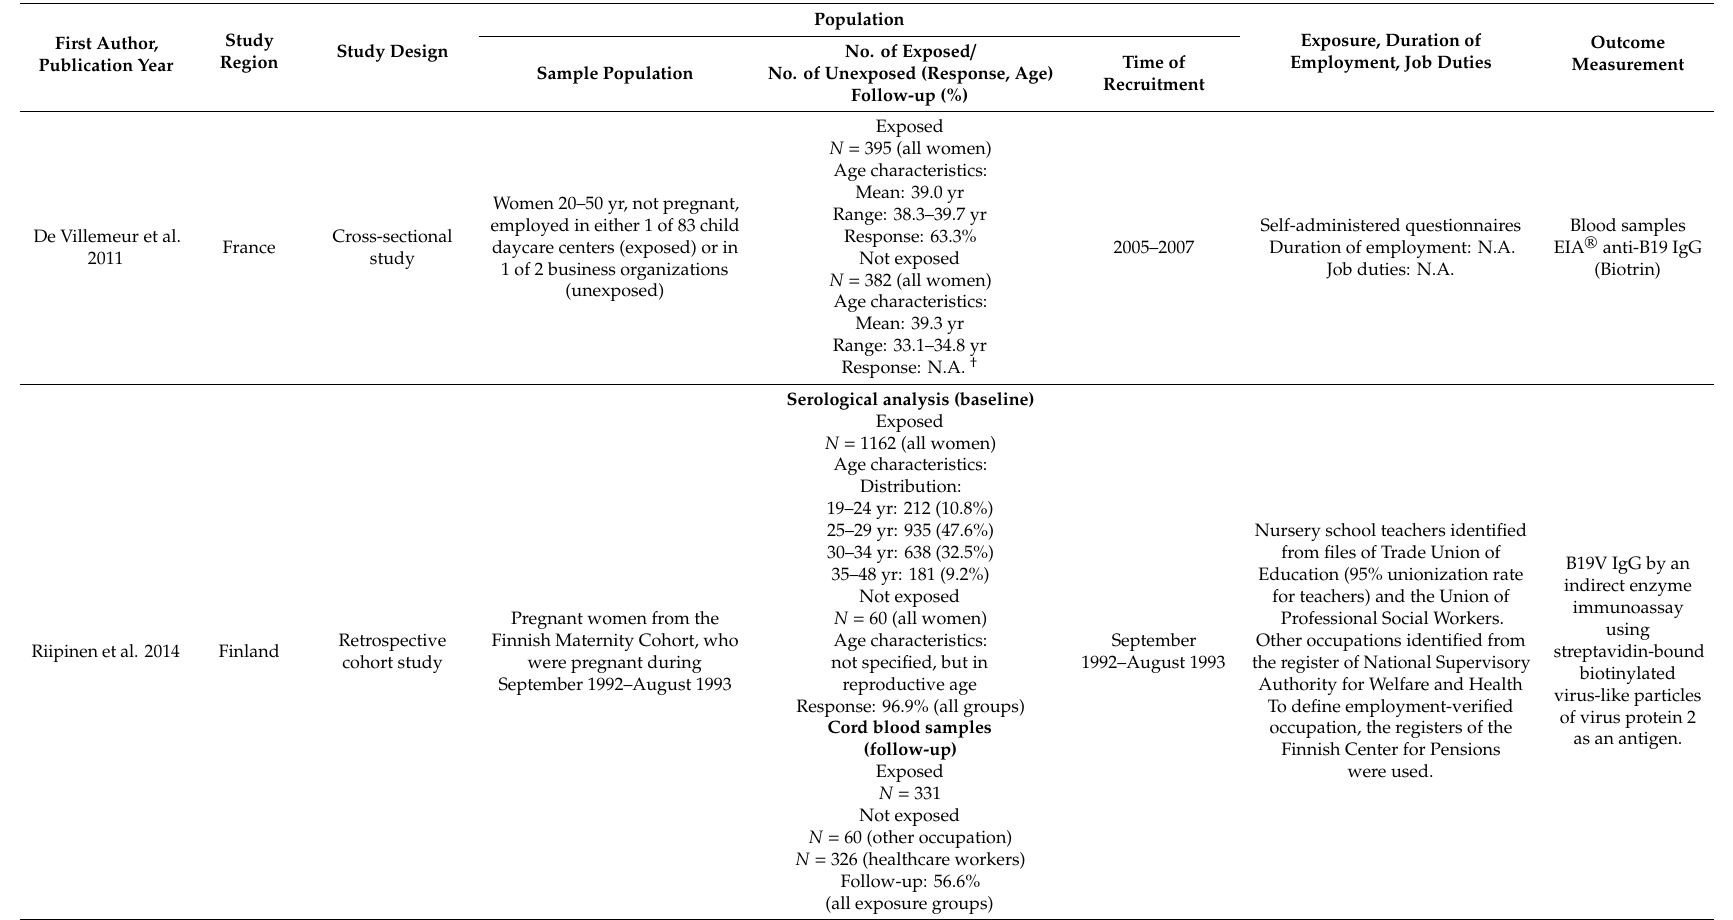
Table 1. The characteristics of the included